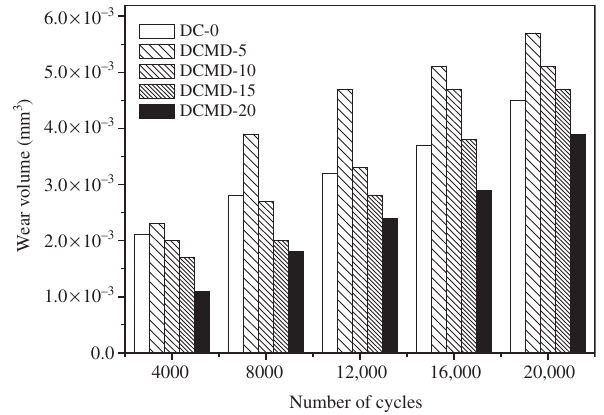
Figure 9: Effect of number of cycles on wear volume of the marble dust-filled dental